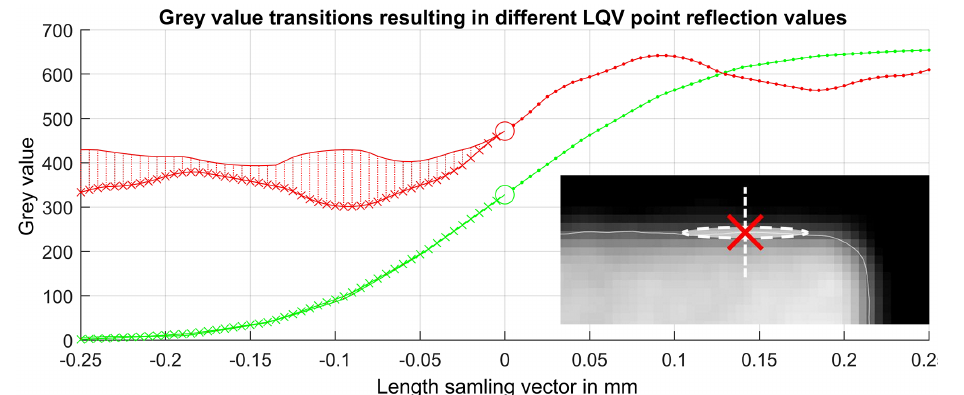
Figure 1. LQV-parameter point reflection: grey value profiles (green and red) are constructed and sampled perpendicular to the determined surface (VGS, small image bottom right). The position x = 0 (marked with circles and red cross in the small image respectively) represents a surface data point. Mirroring of the right function branch ( x > 0) onto the left one ( x < 0) leads to differently sized areas (hatched region) between both function branches, thus resulting in a good or a bad point reflection parameter value (green curve, red curve